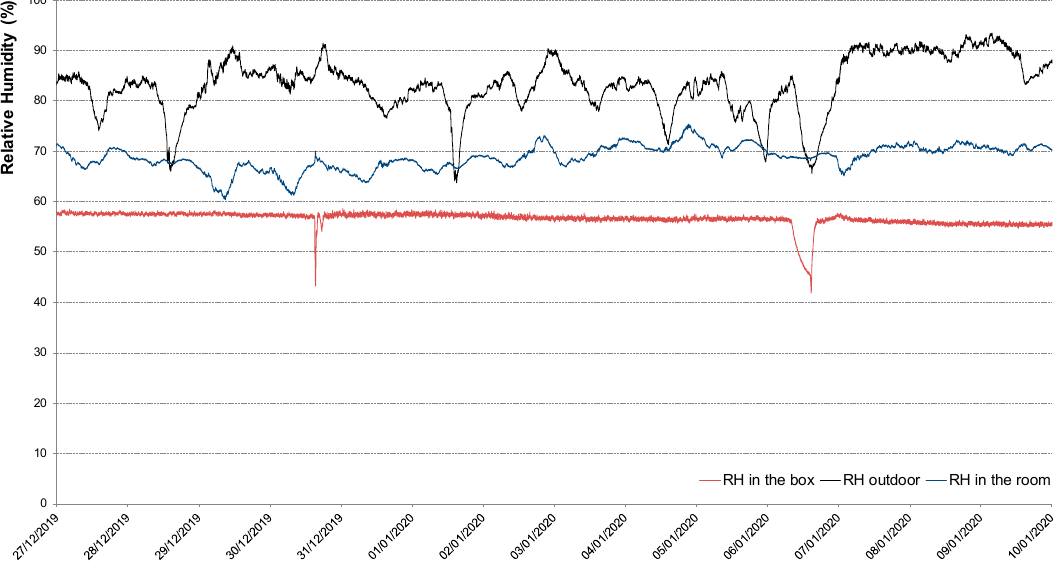
Figure 9. Graphical representation of the monitored parameters [T (°C) and RH (%)] values between